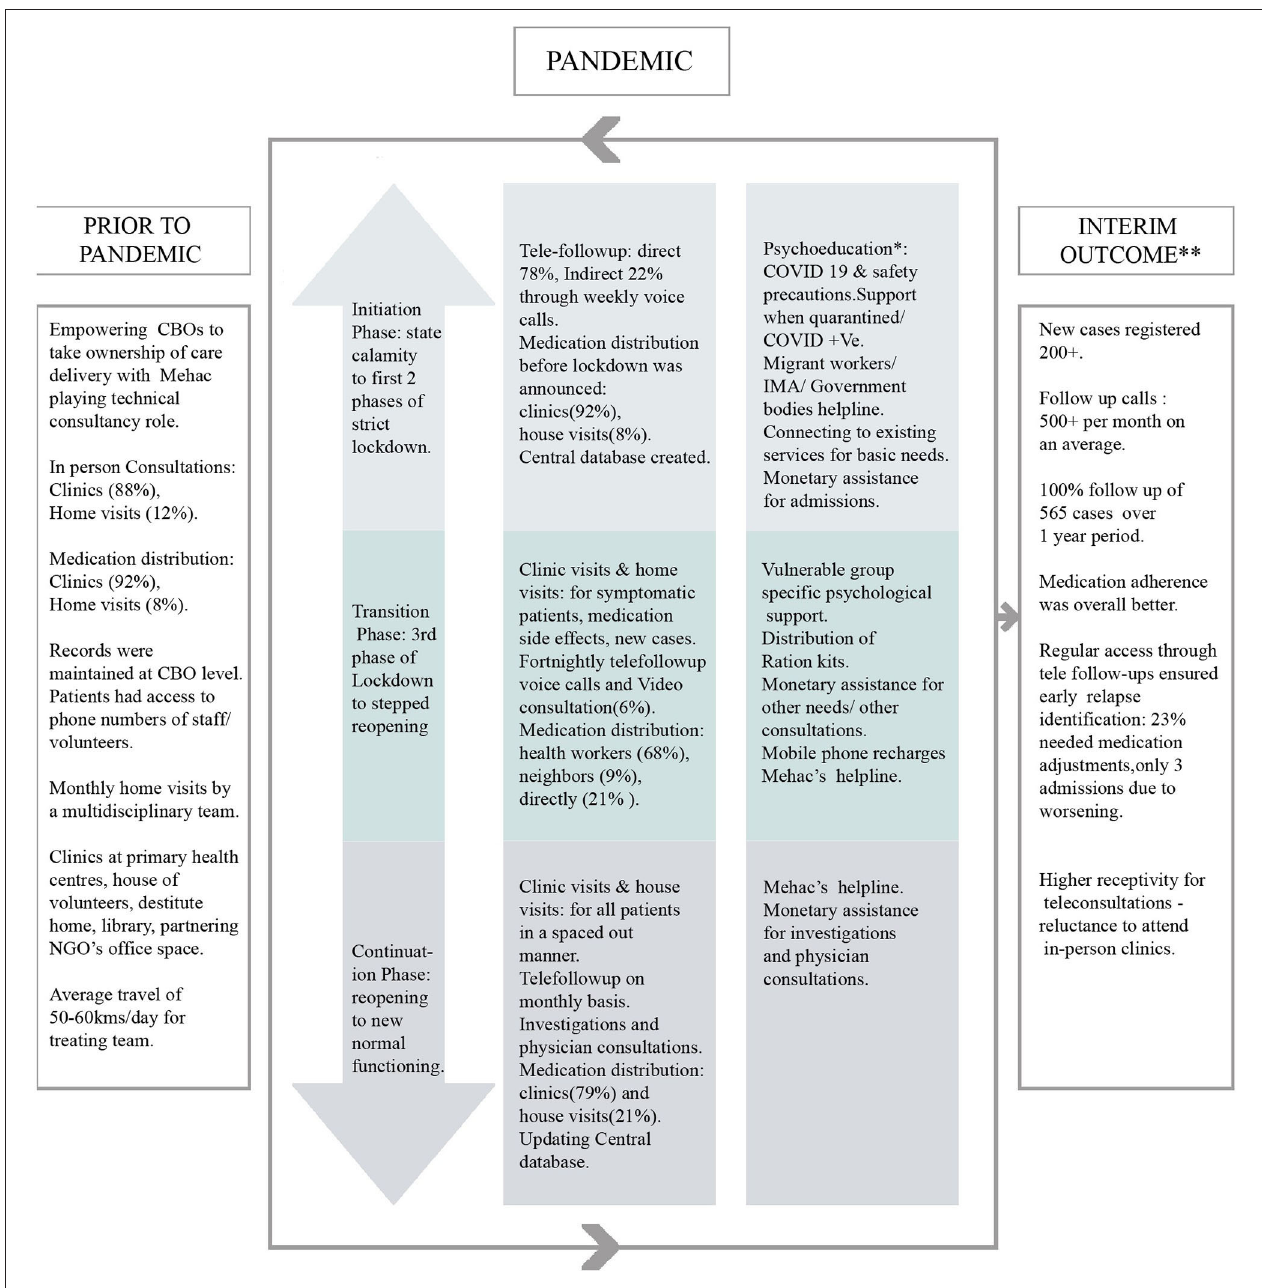
FIGURE 2 | Biopsychosocial response model implemented by Mehac, Kerala, India in response to COVID 19 pandemic.